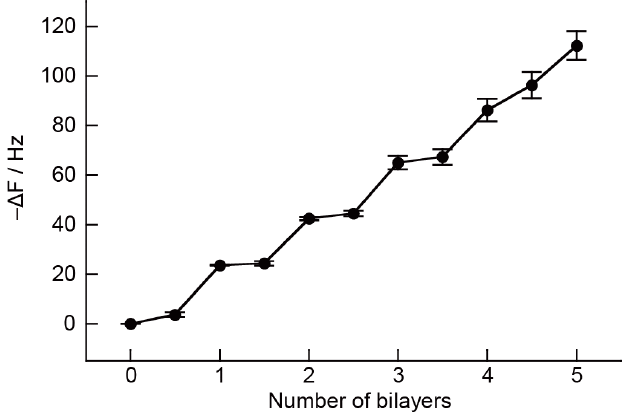
Figure 3. Change in the resonance frequency at each deposition during the (poly(allylamine hydrochloride) (PAH) / AA-PMA) 5 preparation.